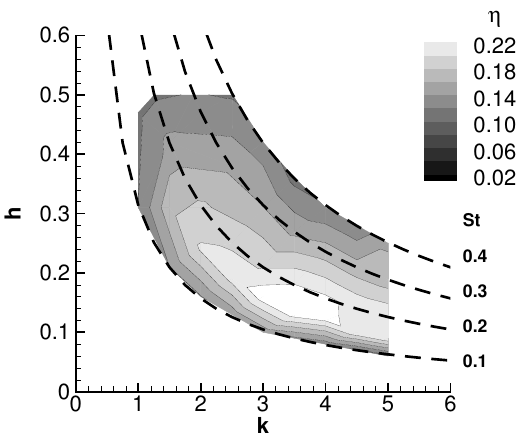
Figure 7. Propulsive efficiency with Re = 8500.